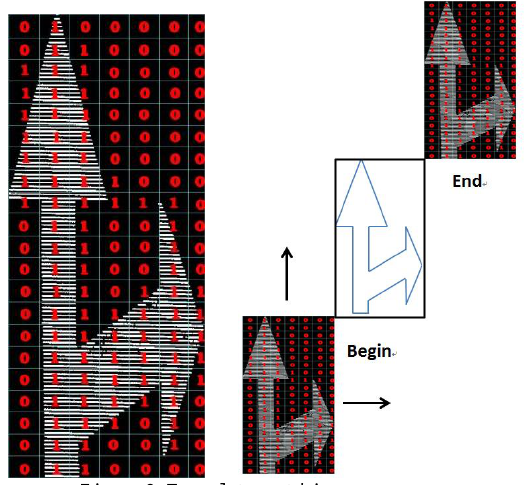
Figure 6. Template matching